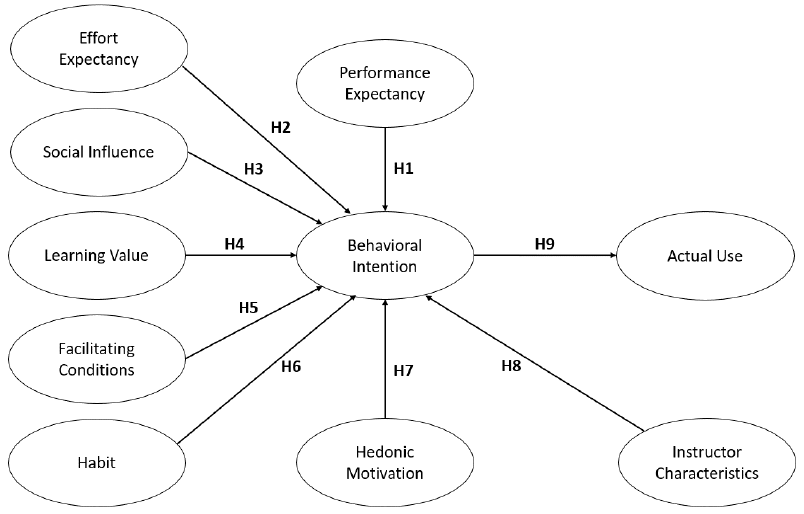
Figure 1. The proposed conceptual framework. Hypothesis 1 (H1). Performance expectancy has a positive influence on a student’s behavioral intentions in using the eLearning platform